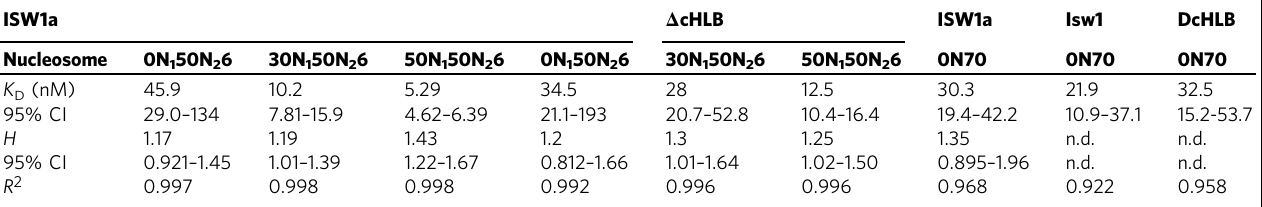
Table 1 Af fi nities of wild-type and mutant ISW1a and Isw1 for mononucleosomes and dinucleosomes. ISW1a Δ